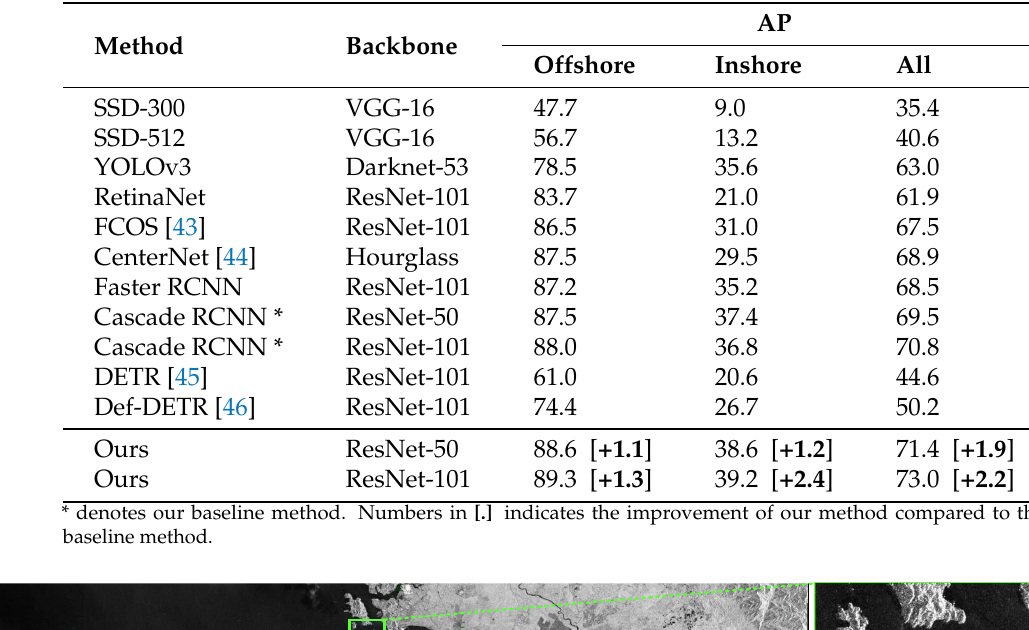
Table 1. Comparison results on LS-SSDD-v1.0.